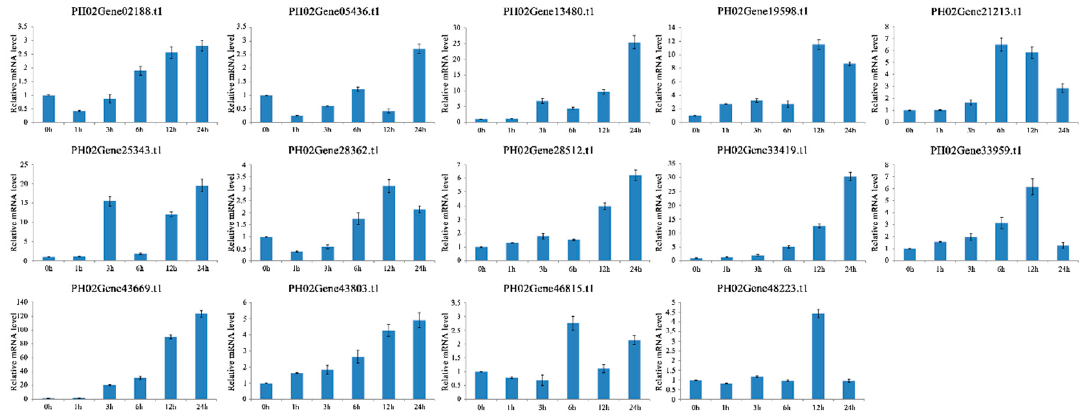
Figure 11. Expression analyses of 14 representative PeUBP genes under SA treatment. Sampling